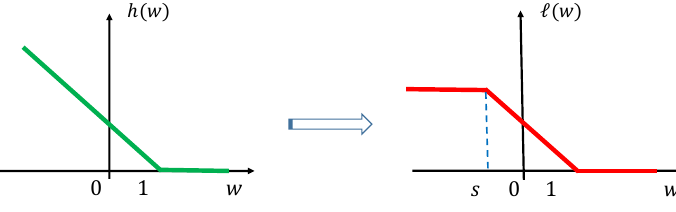
Figure 3. Hinge loss is shown in the first panel and the second panel lists the ramp